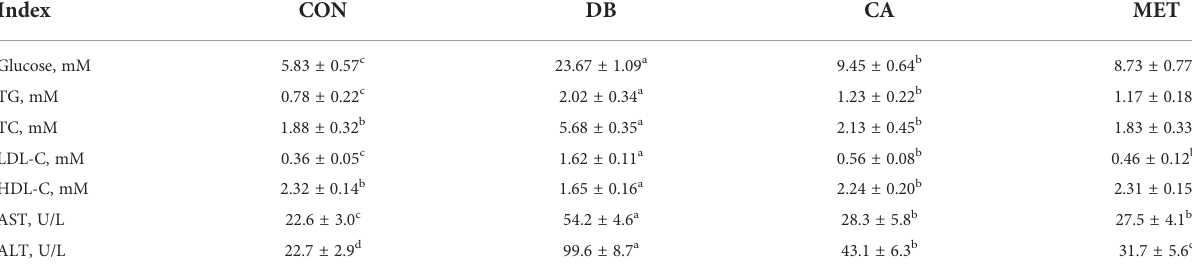
TABLE 3 Effects of chlorogenic acid on serum biochemical indicators in db/db mice.